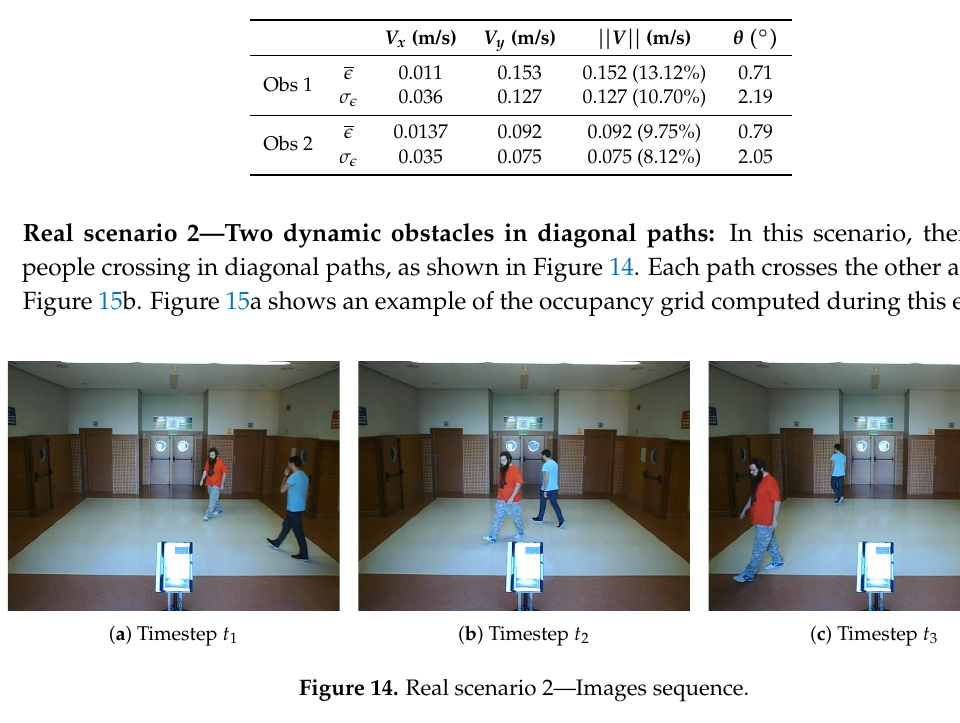
Table 2. Real scenario 1—Errors in velocities detection.